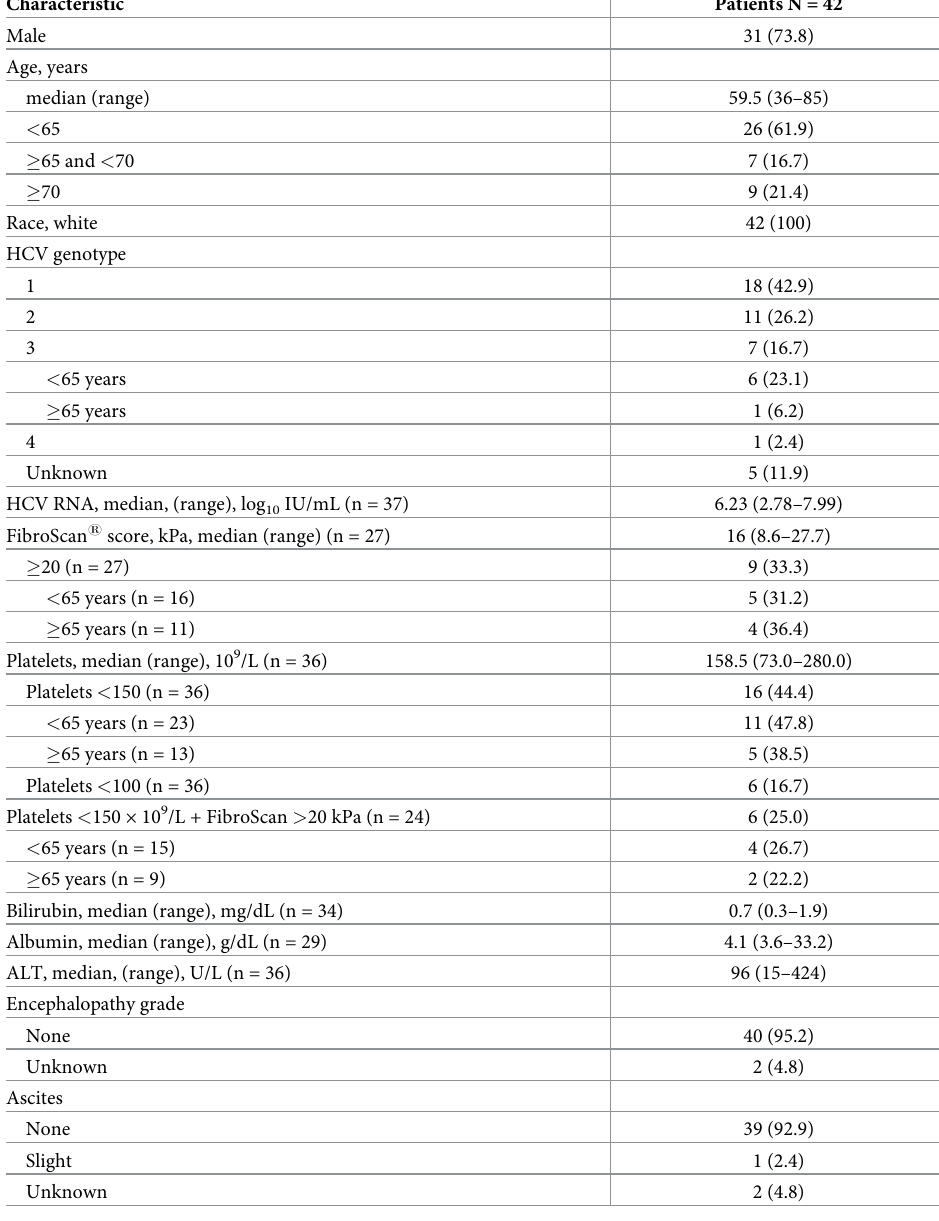
Table 1. Baseline demographics and clinical